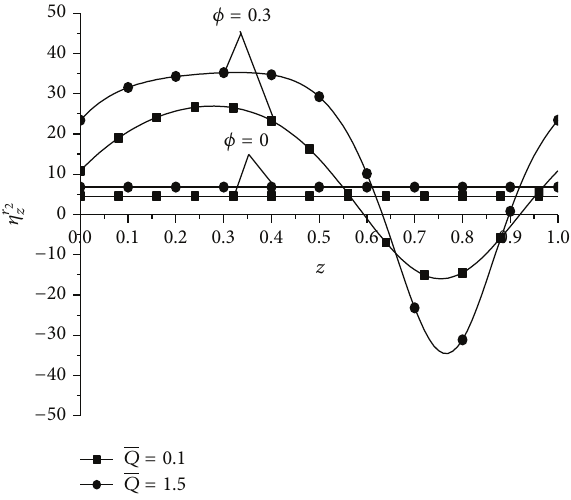
Figure4:Variationofwallvorticity 𝜂 𝑟 2 𝑧 versus 𝑧 withdifferentvalues of 𝛿 and Wi at Re = 5 , 𝜖 = 0.01 , 𝑄 = 1.5 , and 𝜙 = 0.4 .